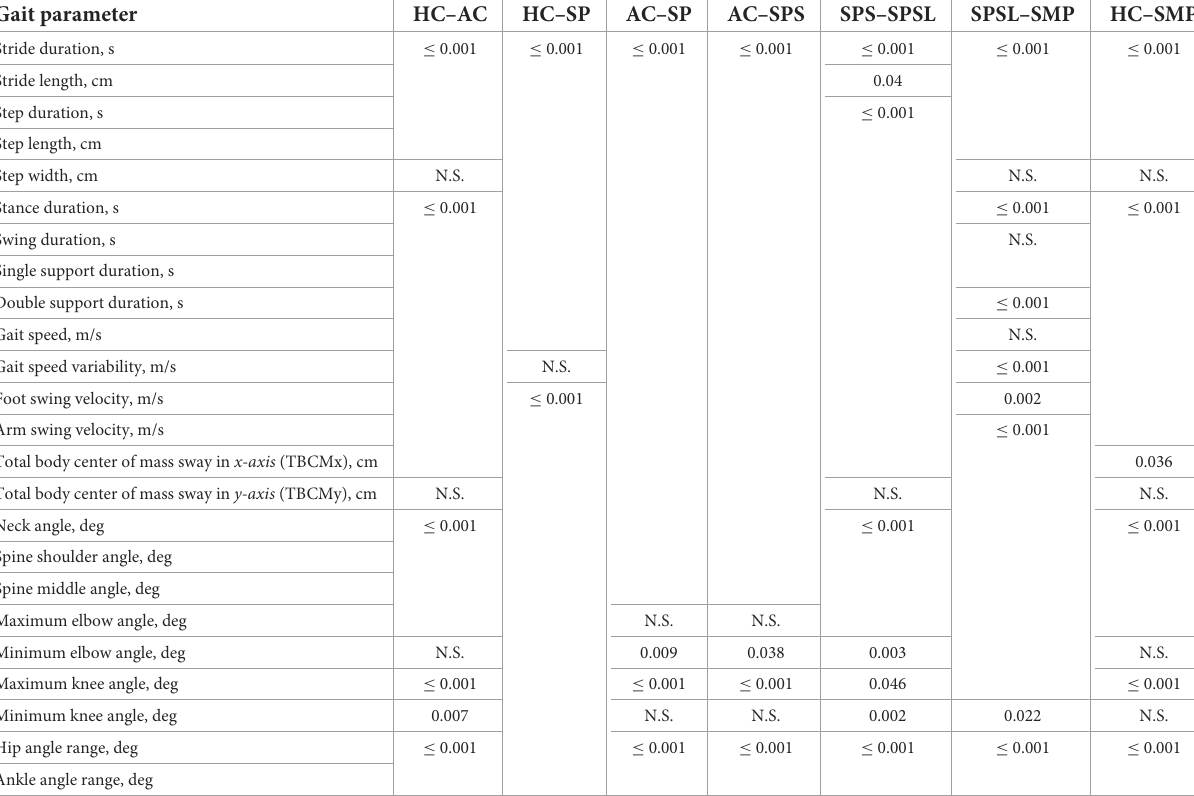
TABLE 3 Results of the Conover-Iman test ( p -value) pairwise comparison between the six groups included in Table 2 (HC, AC, SP, SPS, SPSL and SMP), for each gait